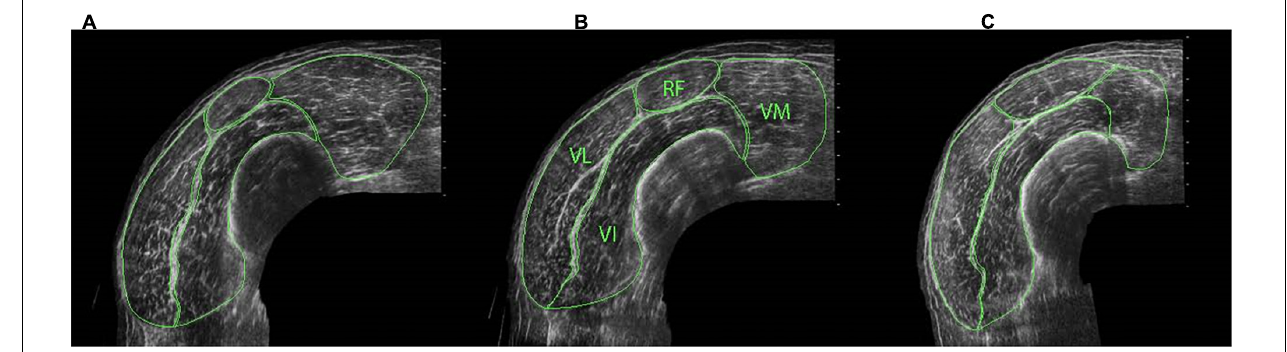
FIGURE 1 | ACSA of individual quadriceps components at distal (A) , middle (B) and proximal (C) regions of the thigh, identifying rectus femoris (RF), vastus medialis (VM) vastus lateralis (VL) and vastus intermedius (VI).